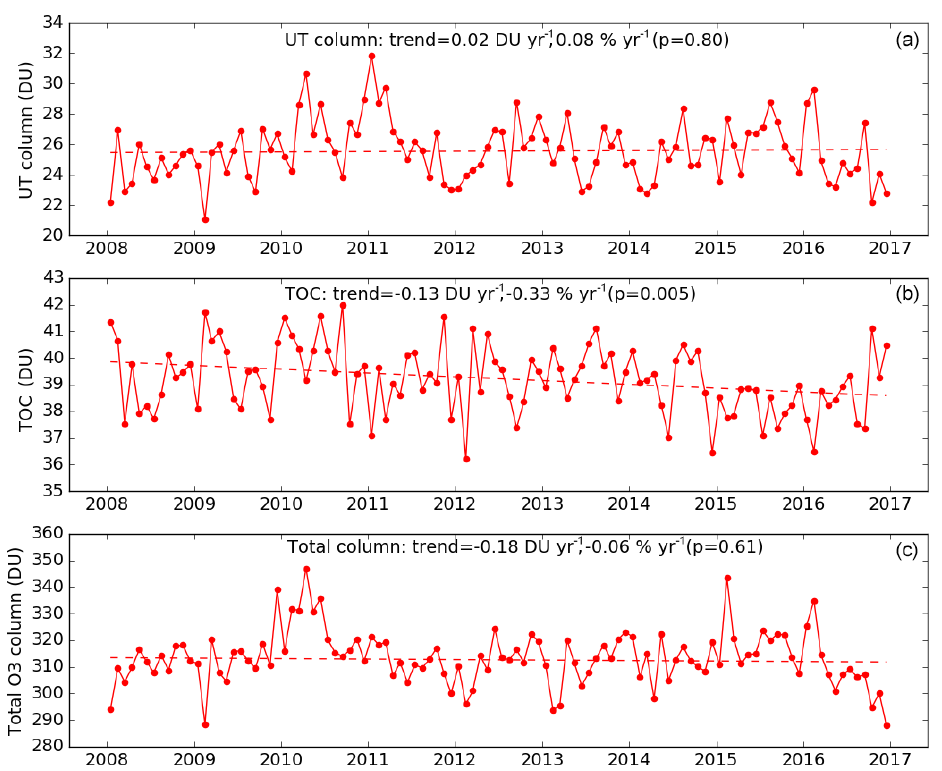
Figure 7. Deseasonalized monthly time series of the upper tropospheric (UT) ozone column (a) , the tropospheric ozone column (TOC, b ), and the total ozone column (c)